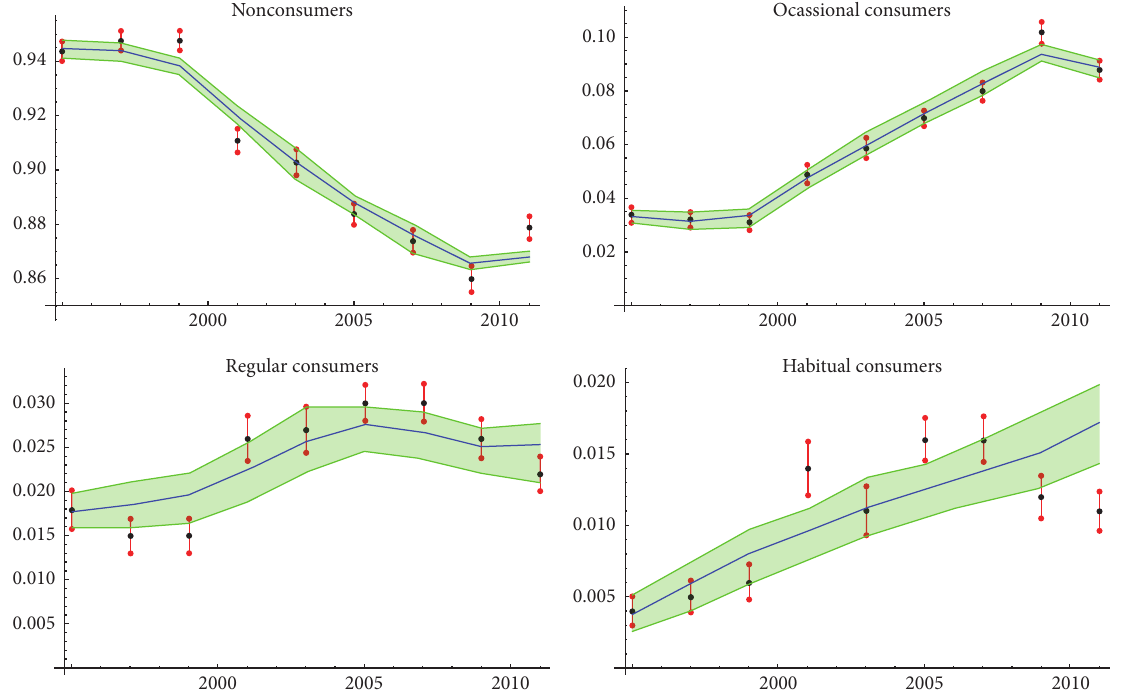
Figure 2: Result of the probabilistic fitting. The green band corresponds to 95 % CI model output and the blue line its mean. The red points are the 95 % CI data given in Table 3 and the black points their means. We can see how the model tries to capture the data uncertainty, but the goal is not achieved